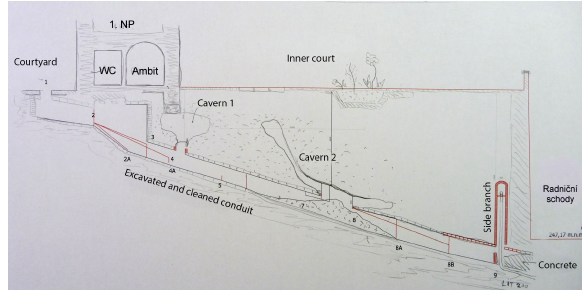
Figure 5. Carmel Monastery: cross section of the main gallery with marks of the